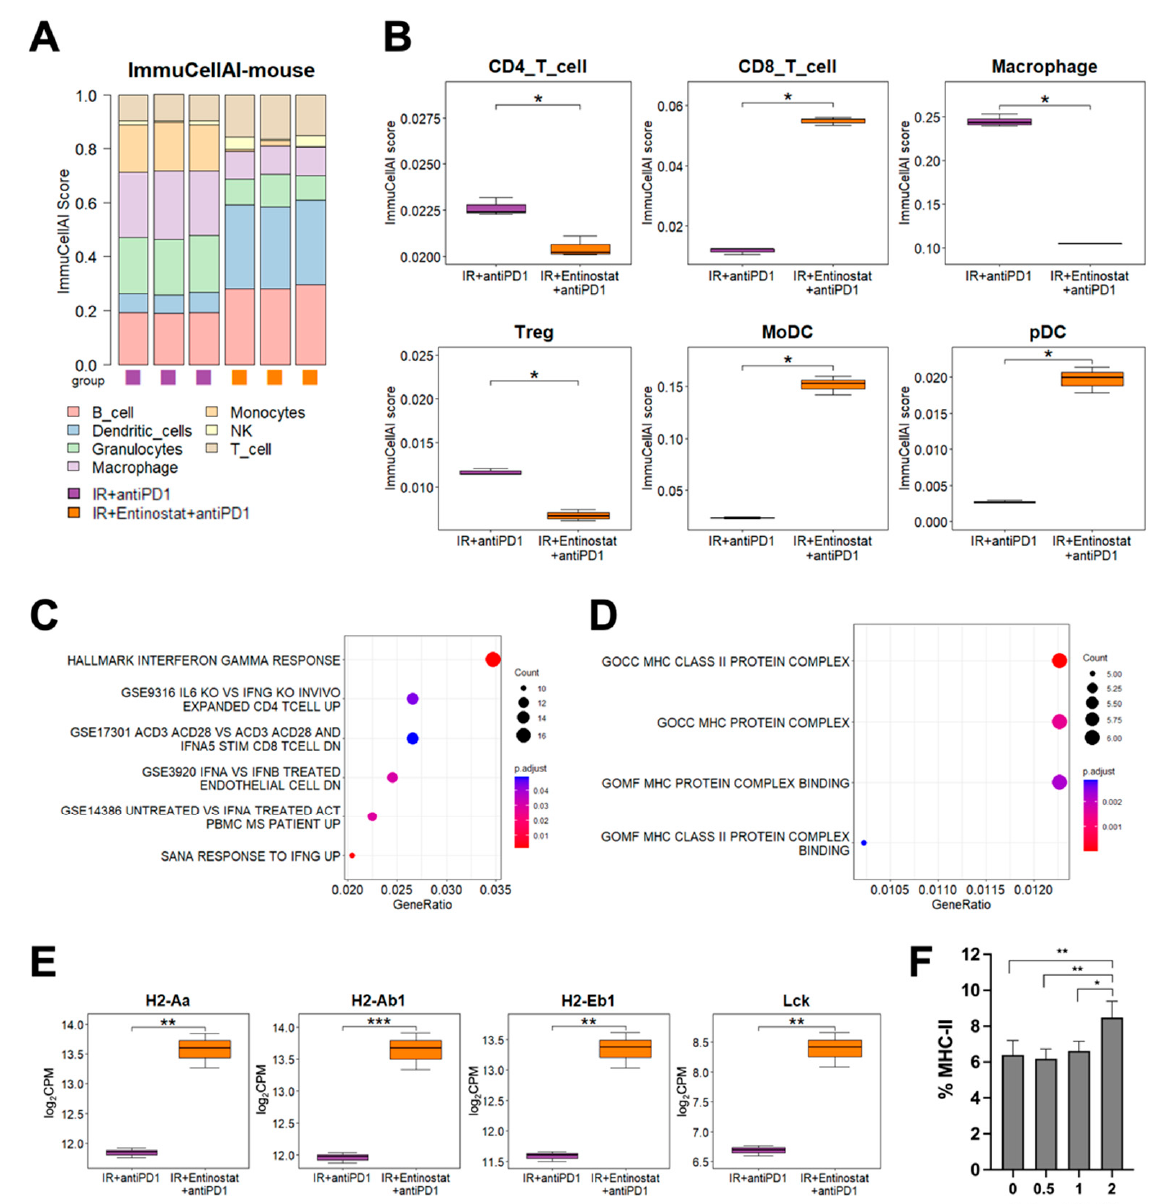
Figure 6. Entinostat potentiates the combination of IR and anti-PD-1 via upregulating IFN- γ and MHC-II pathways ( A ) Comparison of estimated infiltration of different immune cell populations in tumors between IR plus anti-PD-1 group and triple combination group. ( B ) Box plots showing the difference in each immune cell population between the two groups. ( C ) Dot plots showing enrichment of DEGs related to interferon pathways. ( D ) Dot plots showing enrichment of DEGs related to MHC genes between two groups. ( E ) Higher expression levels of MHC-II pathway genes in the triple combination group than those in the IR plus anti-PD-1 group. ( F ) Entinostat induces MHC-II in LL/2 cells. Dose-dependent induction of MHC-II in LL/2 cells, which was assessed by flow cytometry. * p < 0.05, ** p < 0.01, *** p < 0.001.